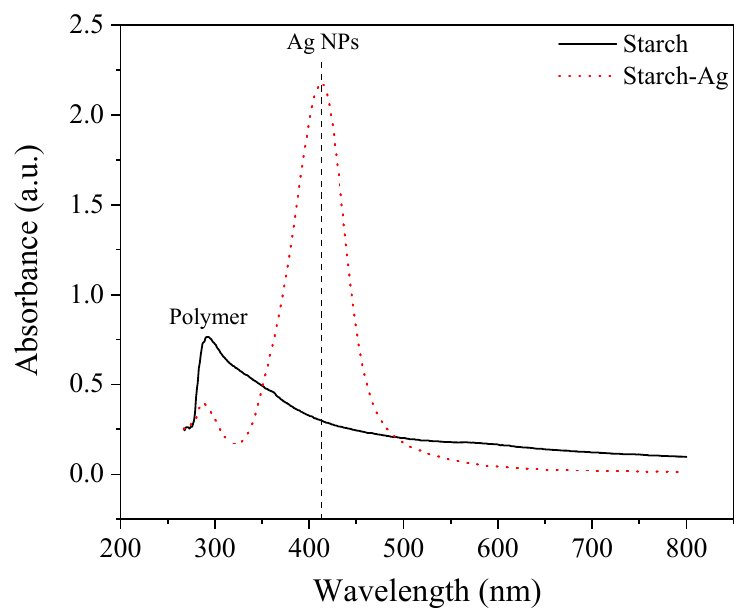
Figure 3. UV-Vis. spectrum of a starch-Ag nanocomposite compared to pure starch. The 1, 1-diphenyl-2-picrylhydrazyl (DPPH) assay was used to evaluate the antioxidant activity of produced St-AgNPs compared to that of ascorbic acid, as shown in Figure 4. The antioxidant activity of St-AgNPs was lower than ascorbic acid at the same concentrations (see Figure 4).